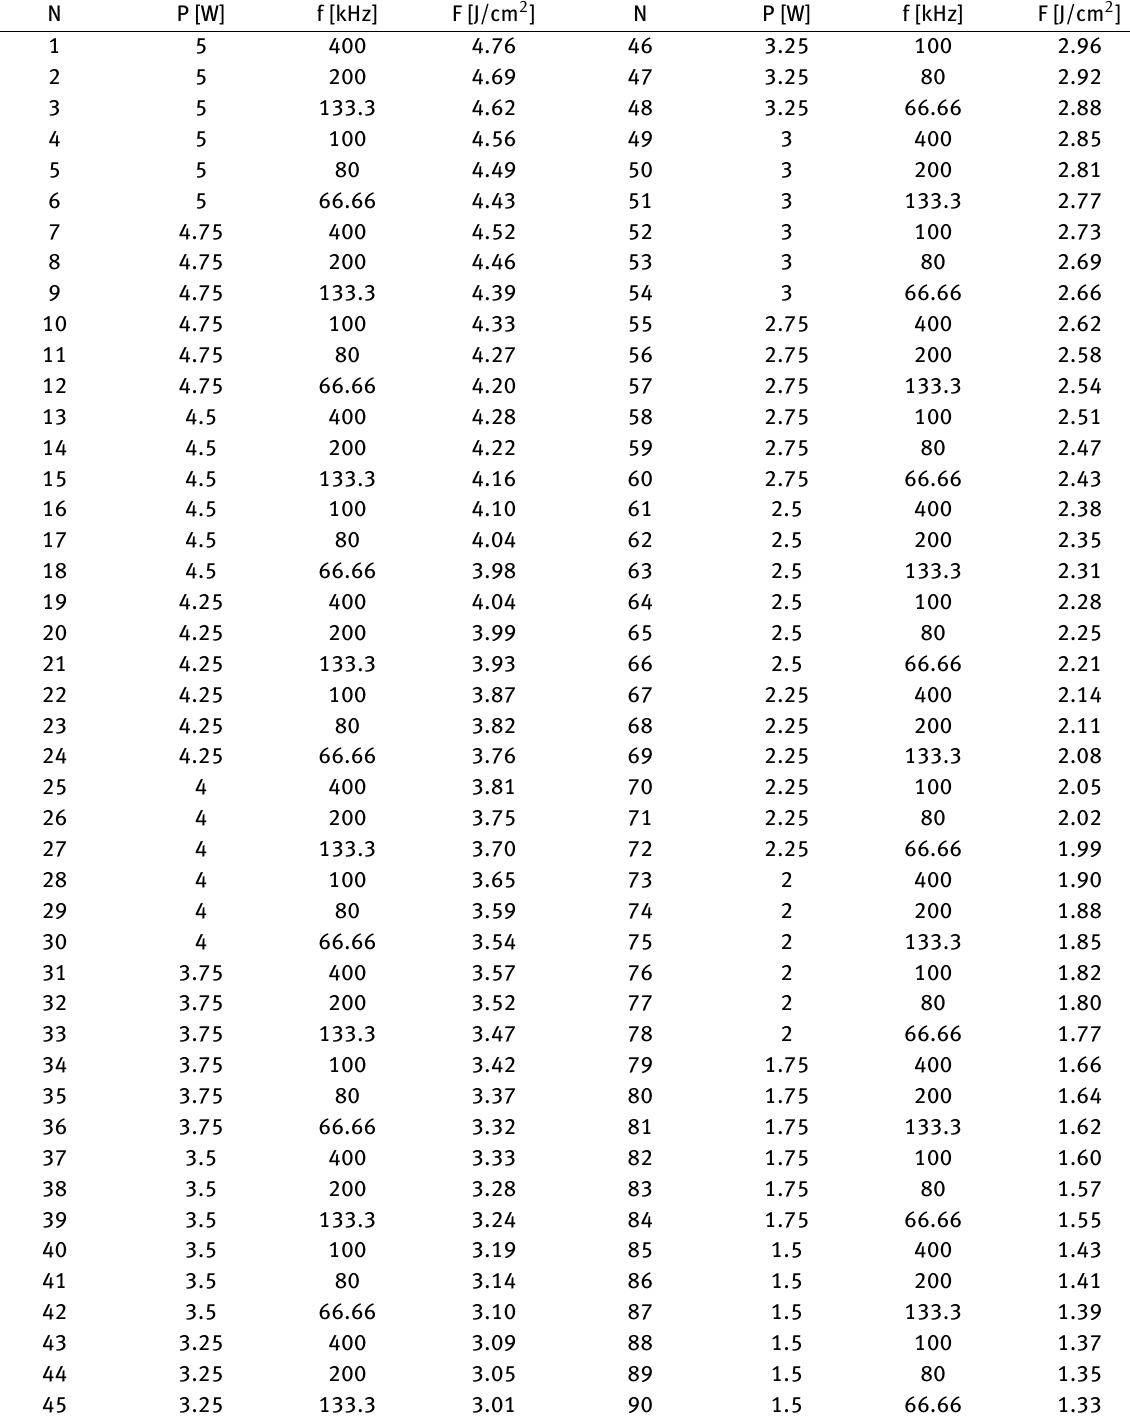
Table 1: Comparison of parameters of laser micromachining of tested